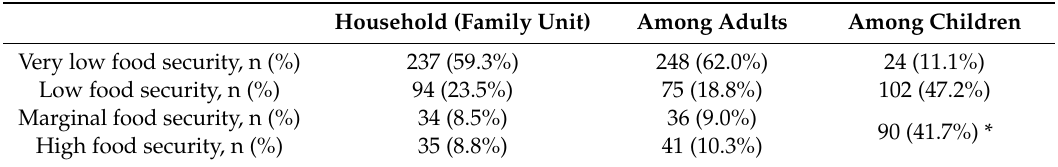
Table 2. Prevalence of food insecurity—proportion of the sample in each category of food security on the USDA Food Security Survey